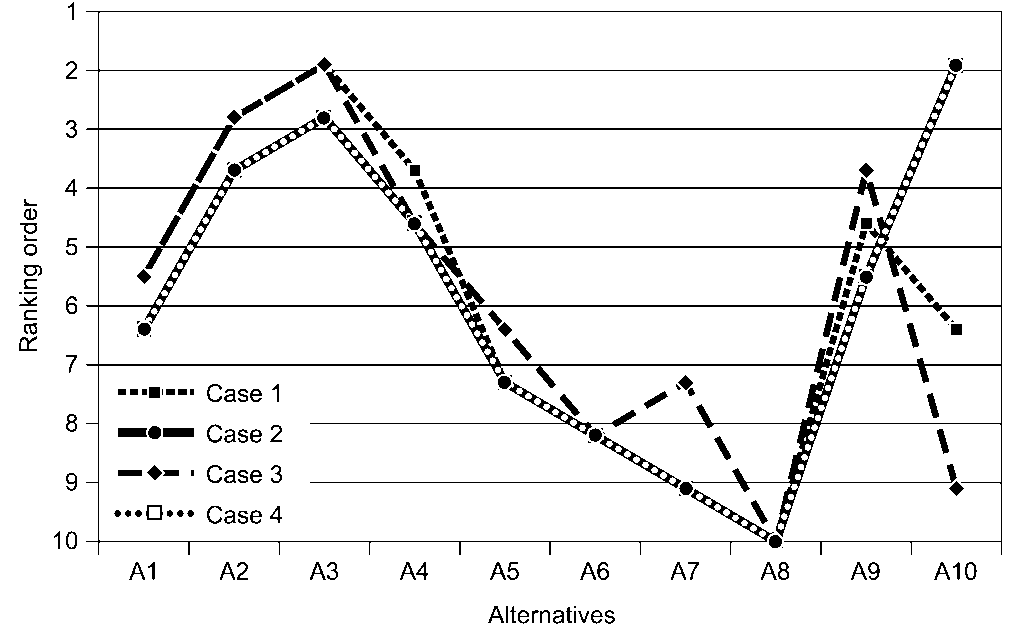
Figure 4. Ranking of alternatives for four different criteria weighting